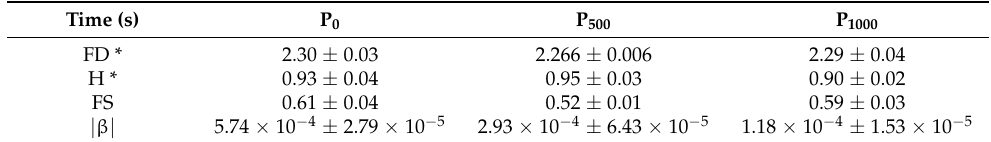
Table 5. Fractal dimension (FD), surface entropy (H), fractal succolarity (FS), and lacunarity coefficient ( β ). Average results are expressed as mean values and standard